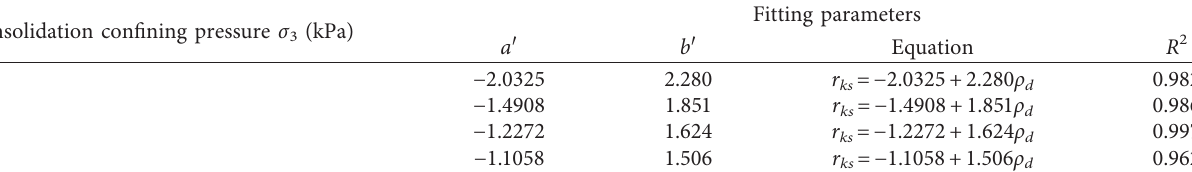
Table 6: Linear fitting parameters under confining pressure consolidation.